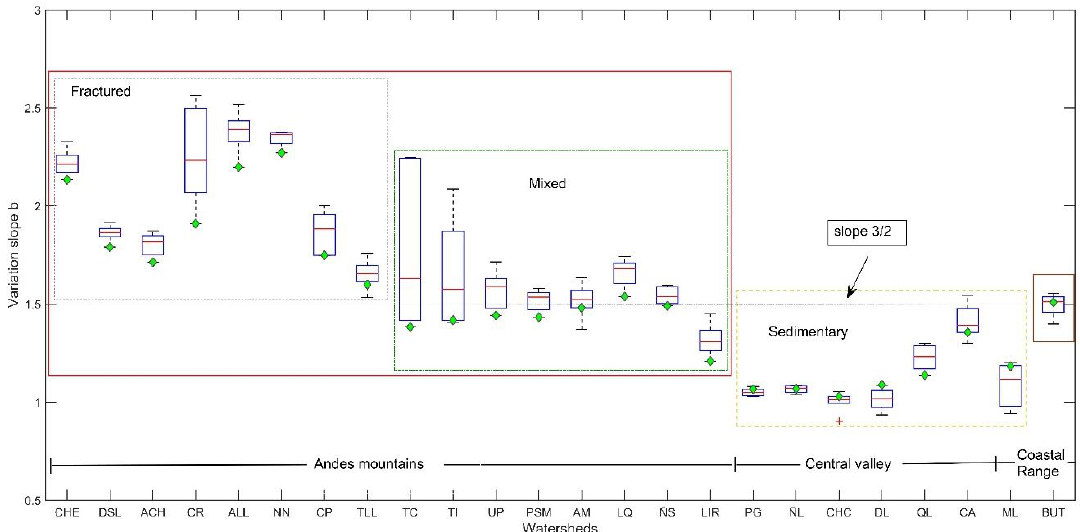
Figure 7. The box plot shows the variation in slope b with various recession starting points. In the initially calculated slope is shown as a point of comparison addition, the initially calculated slope is shown as a point of comparison (diamonds).